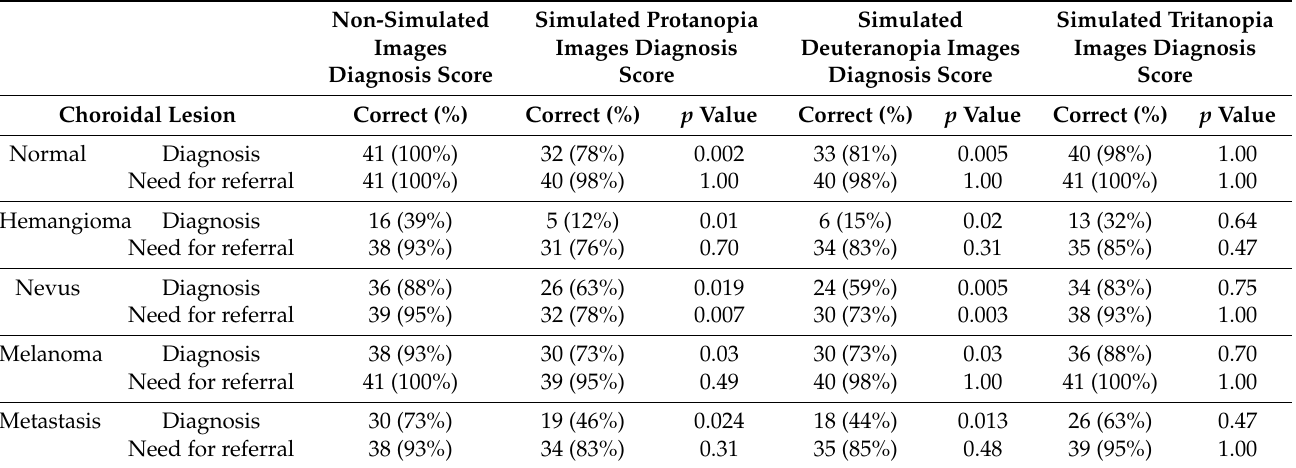
Table 1. Comparing diagnostic accuracy between simulated and non-simulated images for various types of choroidal